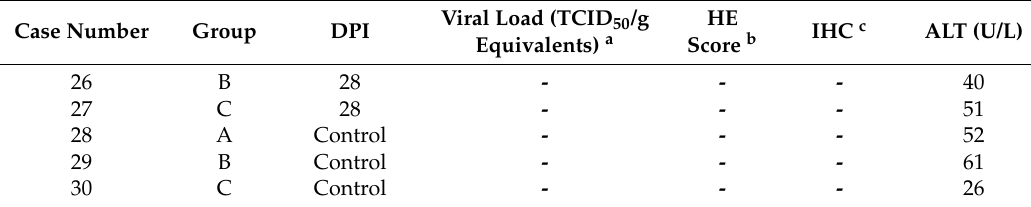
Figure 1. Scatterplots (symbols) and mean values (lines) of complete blood count and leukocyte differentials for Rousettus aegyptiacus bats experimentally inoculated with Marburg virus in a serial euthanasia study; black circles = inoculated bats; open diamonds = mock-inoculated control bats; solid line = mean cell count for inoculated bats; dashed line = mean cell count for mock-inoculated control bats. ( A ) Total white blood cell counts. ( B ) Lymphocyte counts. ( C ) Monocyte counts. ( D ) Granulocyte counts.